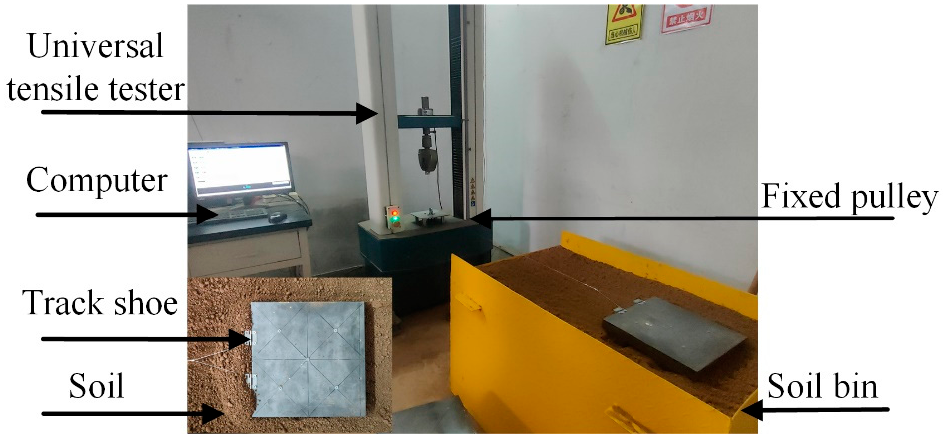
Figure 10. Track shoe test system.